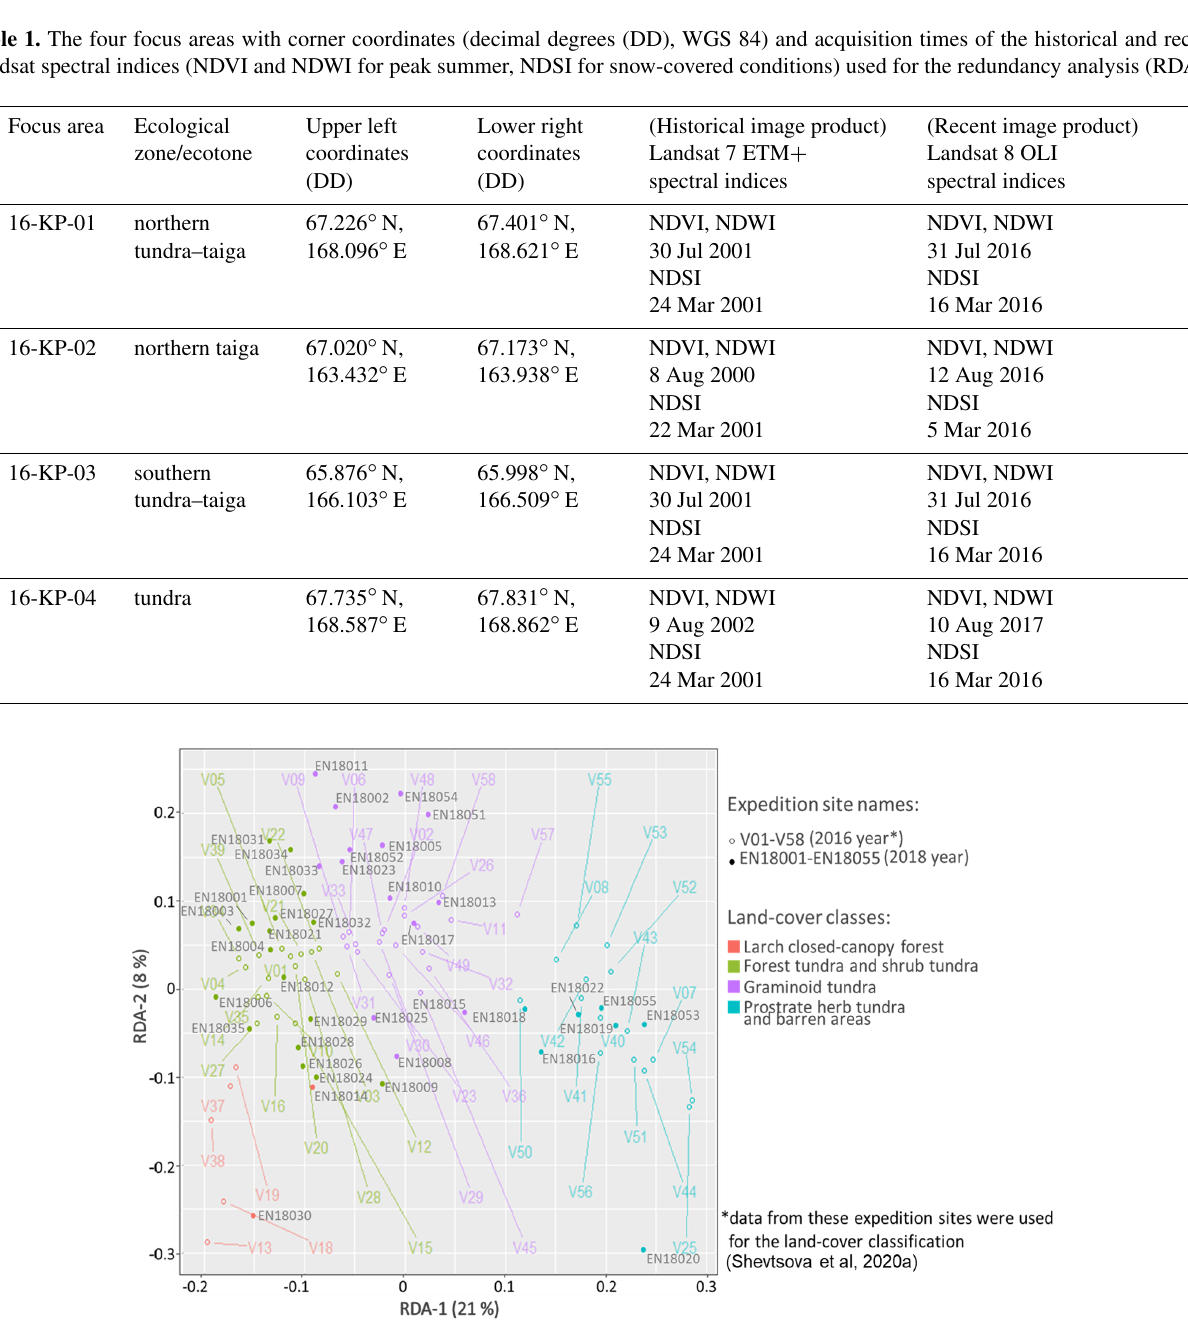
Figure 3. Vegetation data of 2018 expedition sorted into RDA space built using the 2016 expedition vegetation data and assigned to four land-cover classes: (1) larch closed-canopy forest, (2) forest tundra and shrub tundra, (3) graminoid tundra, and (4) prostrate herb tundra and barren